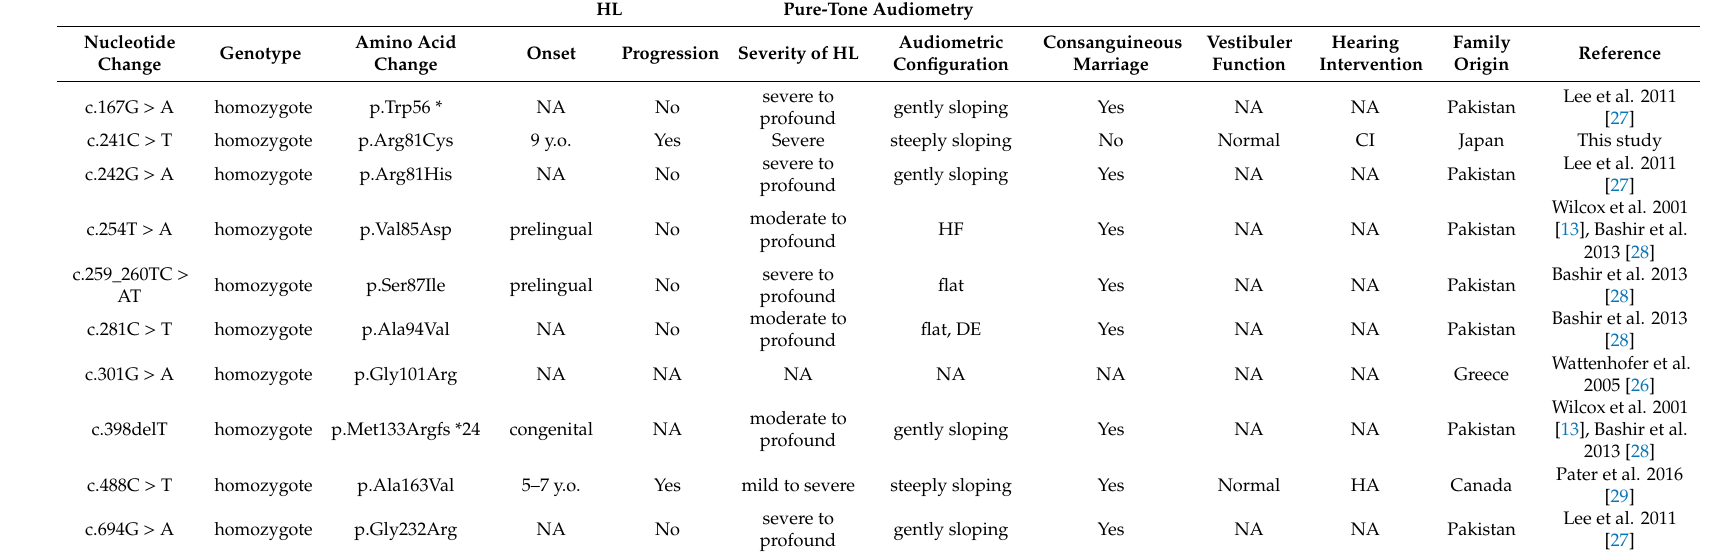
Table 2. Summary of clinical features associated with CLDN14